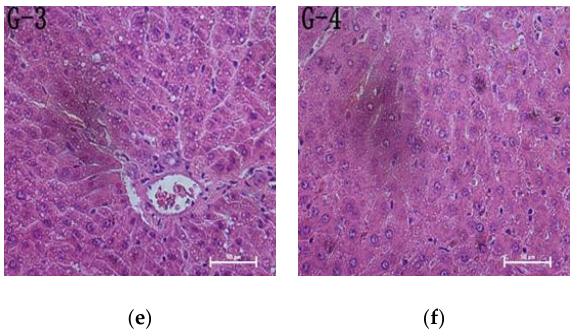
Figure 1. Effect of GOPs on liver histology in rats. Representative photomicrographs with H&E staining reveal histopathological changes of liver (400 × ). GOPs, small molecule oligopeptides isolated from